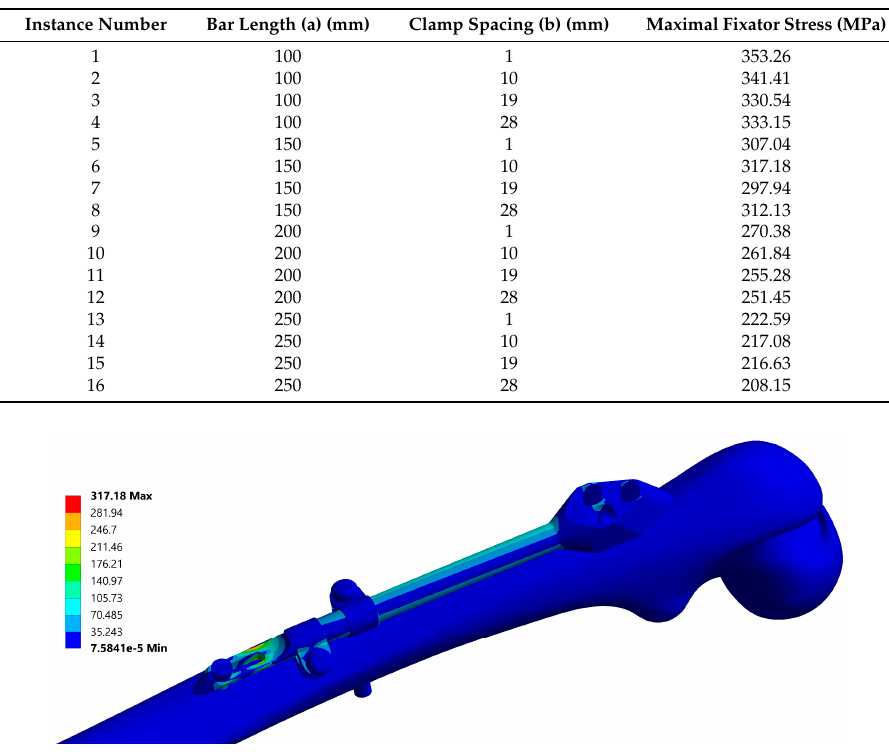
Figure 6. Equivalent stress field of the fixator, corresponding to the instance no. 6 (Table 2).